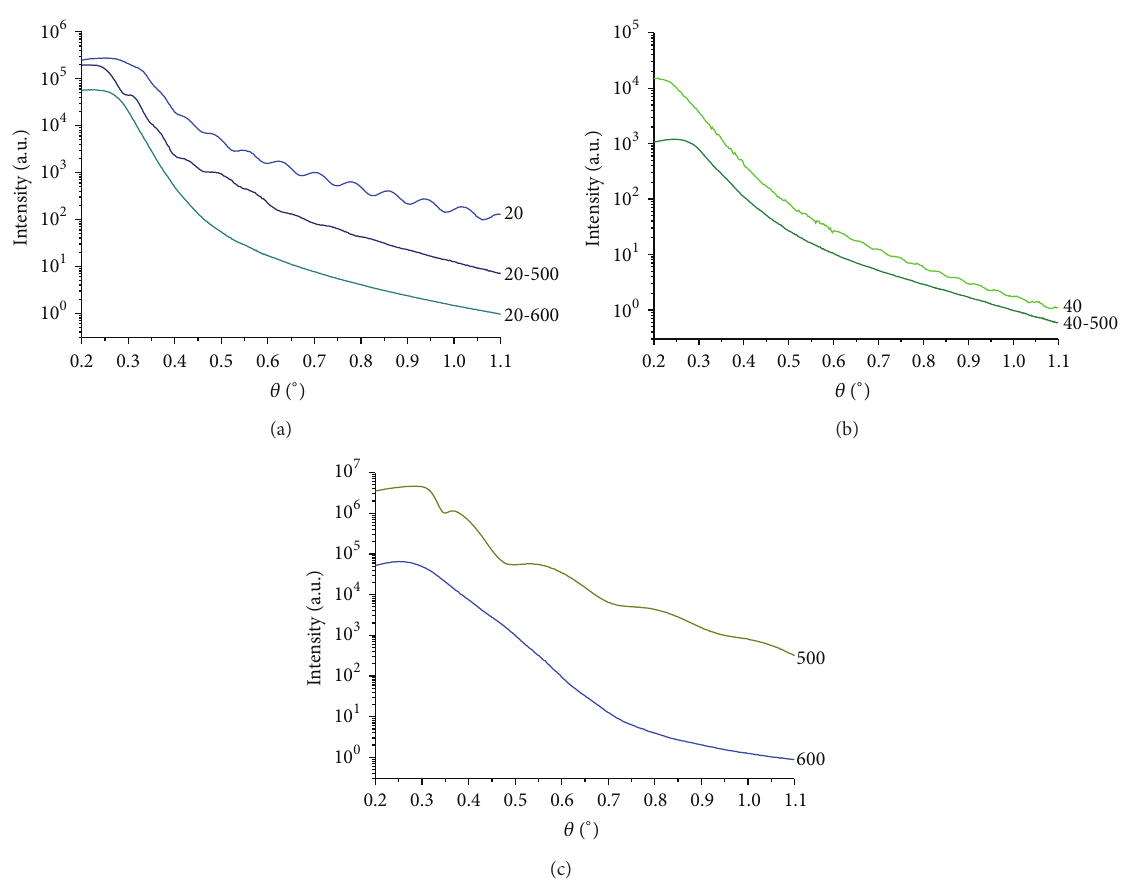
Figure 2: XRR curves of the samples oxidized by (a) anodic oxidation at 20 V with and without heat treatment; (b) anodic oxidation at 40 V with and without heat treatment; (c) thermal oxidation in air at 500 ∘ C and 600 ∘ C.